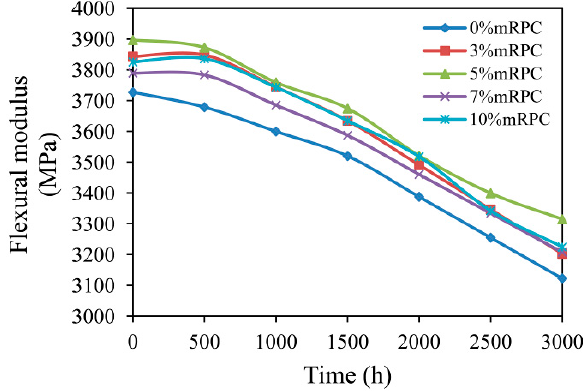
Figure 9. Effect of mRPC mass percentage and aging time on flexural modulus.